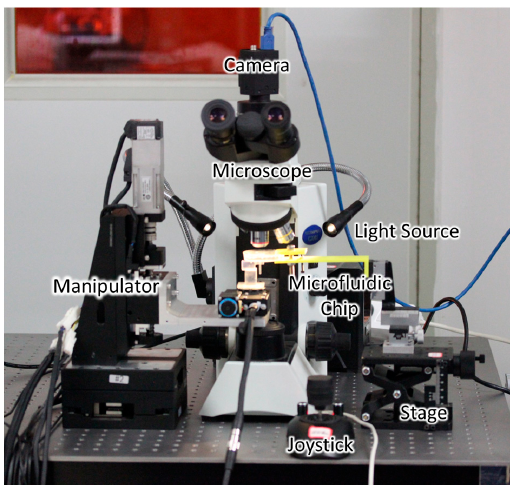
Figure 5. Overview of the manipulation system.